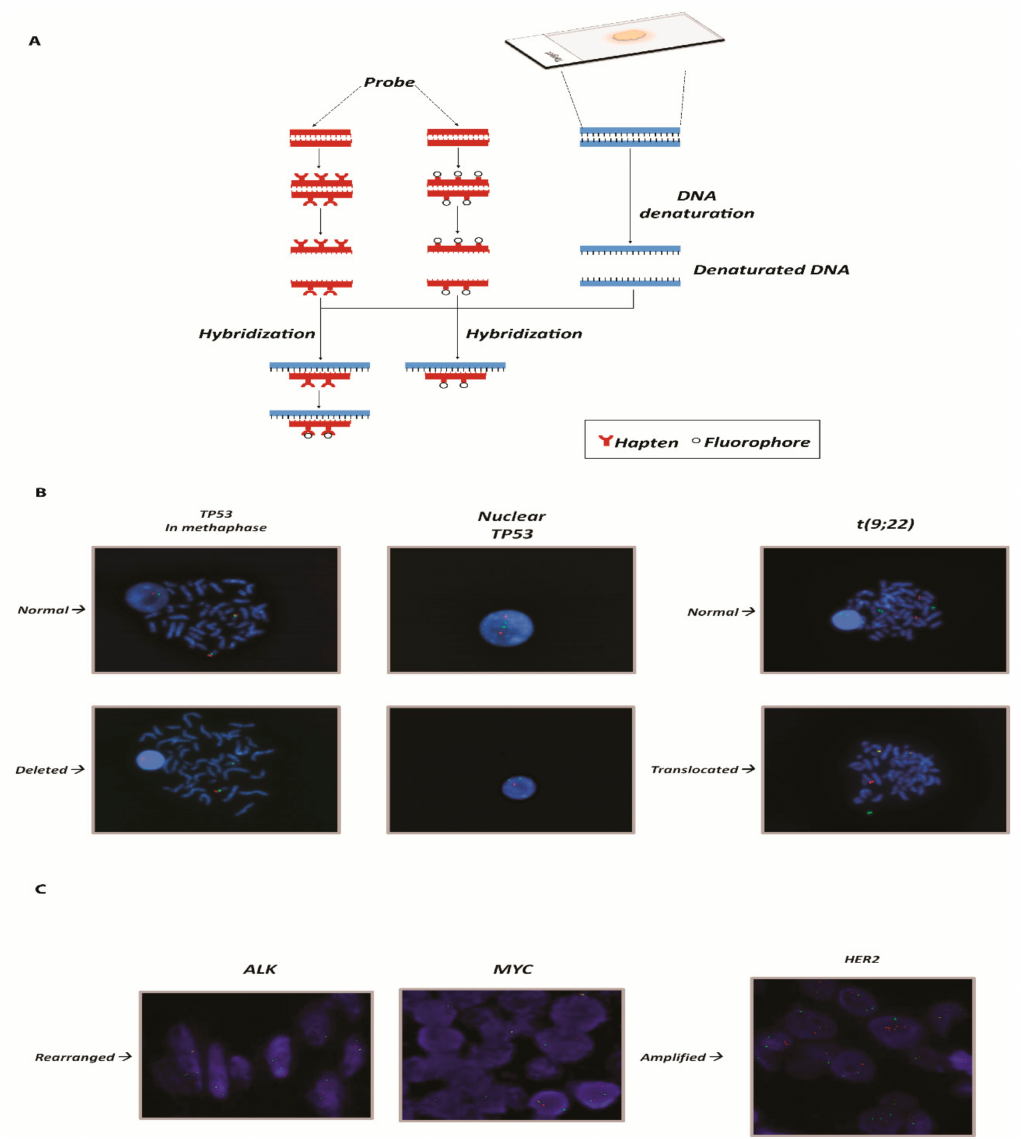
Figure 1. ( A ) Graphical representation of the FISH technique: from the adhesion of the nucleic acid to the hybridization of the probes. ( B ) On the left panels, example of a gene deleted in chronic lymphocytic leukemia. The slides show the TP53 gene (17p13.1) represented by the red spot [cosmid probes for TP53 deletion (Cytocell)] and the control (centromere 17) by the green spot. In the normal nucleus and metaphase, the number of red spots is equal to the number of green spots and they are both diploid. In the deleted nucleus the number of red spots is equal to 1, instead of two. On the right panels, example of translocation in chronic myeloid leukemia. The translocation in question concerns the t(9;22) of the genes ABL (9q34.12) and BCR (22q11.21), known as the Philadelphia chromosome. In the upper slide a normal karyotype is represented. BCR and ABL are clearly distinguishable and highlighted by a dual fusion cosmid probes for BCR/ABL (ABL1) translocation. The lower slide shows the translocation: the two spots overlap and are displayed as a yellow spot. ( C ) Example of rearranged and amplified genes: on the left ALK and MYC genes, respectively, in cervical cancer and B-cell lymphoma. The rearrangement in FISH can be seen because the two spots, one that identifies the gene (red tag; LSI ALK dual color break apart probe (Vysis) and LSI MYC dual color break apart rearrangement probe (Vysis)) and one that identifies the centromere, which is used as a control (green tag), are distant. On the right panel, example of amplification of the HER2 gene in breast cancer. The red spots (identified in the images by dual color probe LSI HER2 spectrum orange) that identify HER2 gene are in a greater number compared to the green spots that identify the control, represented by centromere 17 (CEP17 Spectrum Green PathVysion Vysis). DAPI staining (blue) is used for the nuclei morphology in all the presented panels. The magnification is 63 ×